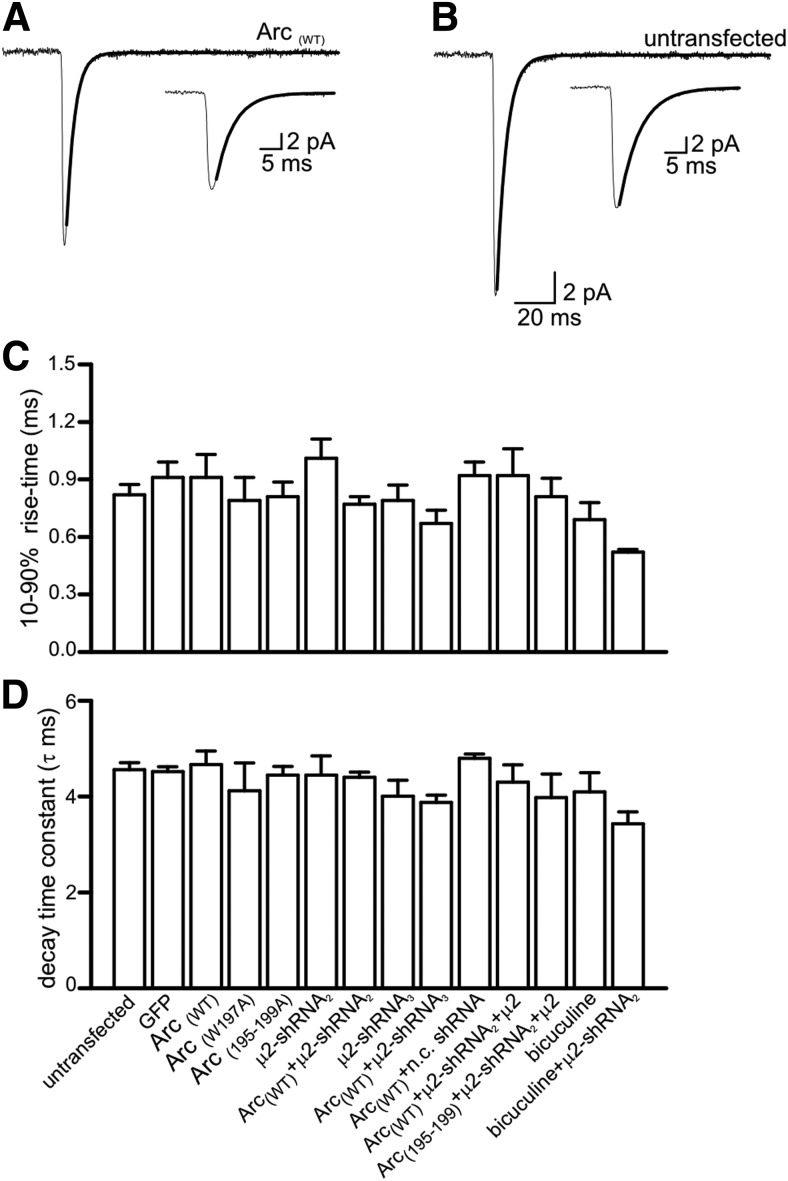
Overexpression of Arc-cDNAs does not affect AMPAR-mediated mEPSC kinetics in hippocampal neurons. A, Average of 75 mEPSCs aligned on the midpoint of the rising phase) from an individual neuron expressing Arc(WT). The decay was fitted with a single exponential (τ = 4.5 ms, black line). Inset, The average mEPSC at an expanded time base showing the exponential fit to the decay. B, Average of 80 mEPSCs (aligned on the midpoint of the rising phase) from an untransfected neuron which was a close neighbor to the cell in A. The decay of the mEPSC was very similar to the transfected neighbor (the decay was fitted with a single exponential; τ = 4.7 ms, black line). Inset, The average mEPSC at an expanded time-base to show the exponential fit to the decay. C, Bar chart plotting the mean 10–90% rise time of mEPSCs recorded from untransfected neurons (n= 18) and from neurons expressing different constructs and in different conditions (n = 6 for each). The mean rise time was calculated by averaging the rise time of mean currents from individual recordings. There was no significant difference in the mean mEPSC rise time recorded from any of the neurons. D, Bar chart plotting the mean decay time constant (τ) from untransfected neurons (n=18) and from neurons expressing different constructs and in different conditions (n=6 for each). The mean decay time constant (τ) was calculated by averaging the time constant from the decay of mean currents from individual recordings. The decay of mEPSCs was not significantly different between conditions. The error bars in C and D are SEM. Statistical significance was tested using the Mann–Whitney test